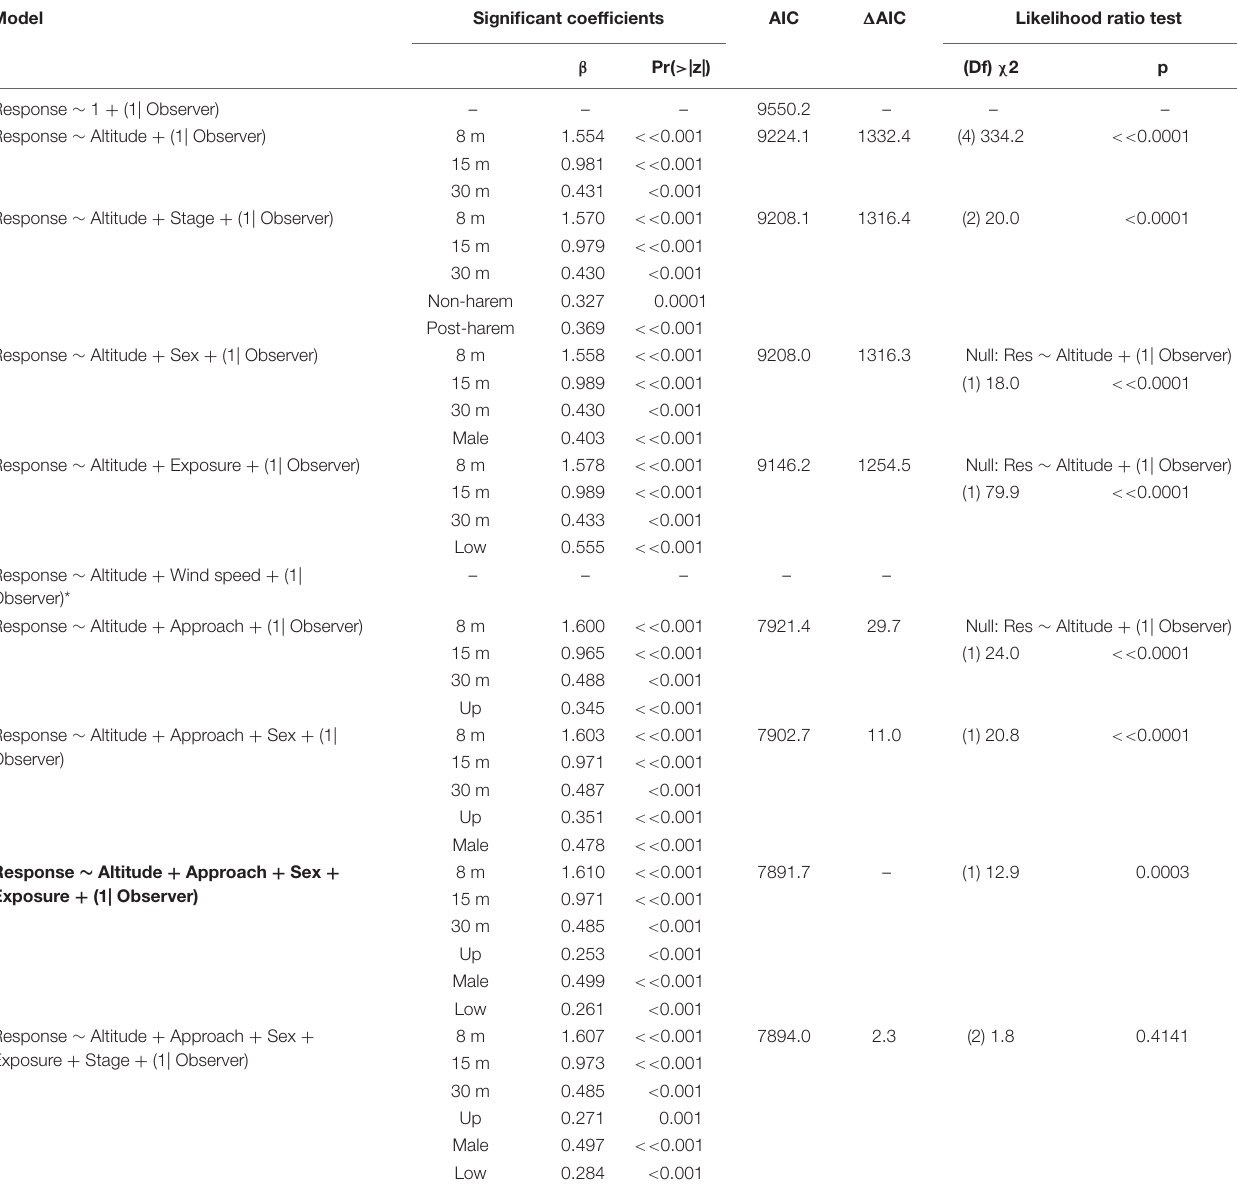
TABLE 7 | Generalized ordinal logistic mixed effects model results of behavioral response scores ( n = 4,254) from Antarctic fur seals at Cape Shirreff, Livingston Island in 2017 and